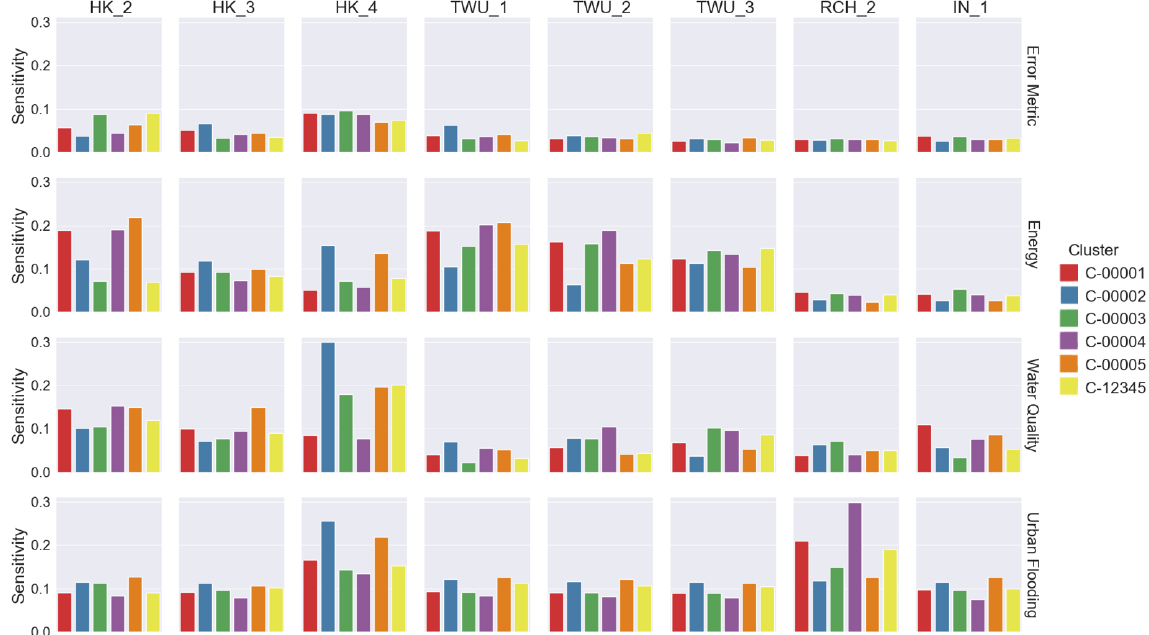
Figure 6. δ sensitivity of the error metric and three management objectives (rows) according to the 5000 filtered samples for the eight model parameters (columns) with the largest differences in sensitivity between clusters for the historical management alternative. The sensitivity is shown by cluster in order, from left to right, i.e., C-00001, C-00002, C-00003, C-00004, C-00005, and C-12345.